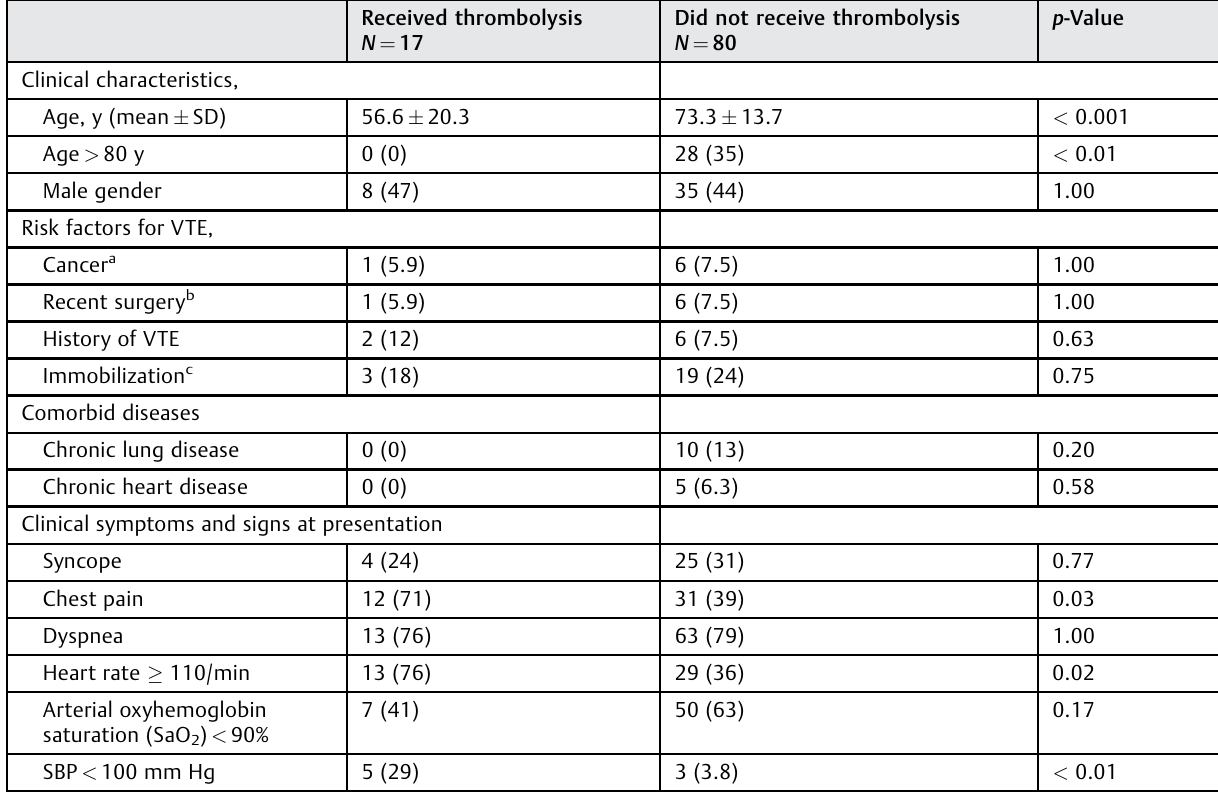
Table 2 Clinical characteristics of patients with intermediate-high risk PE ( n ¼ 97) who did or did not receive